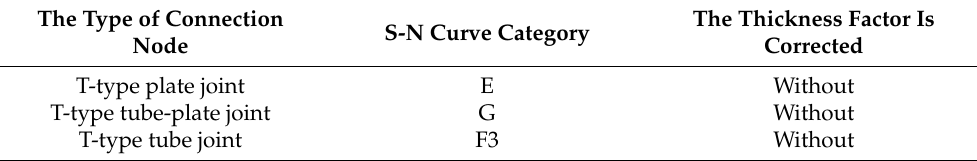
Table 10. Three T-type tube-plate joints correspond to the S-N curve